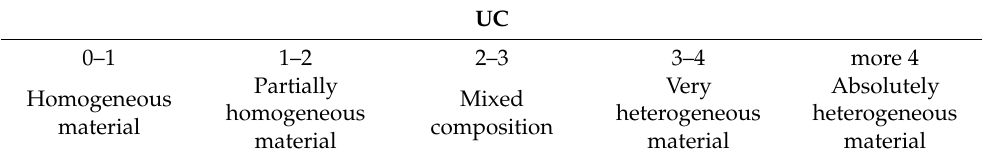
Figure 11. Influence of cryogenic exposure on the homogeneity of the material. Table 6. Scale of bulk material homogeneity according to particle size distribution.